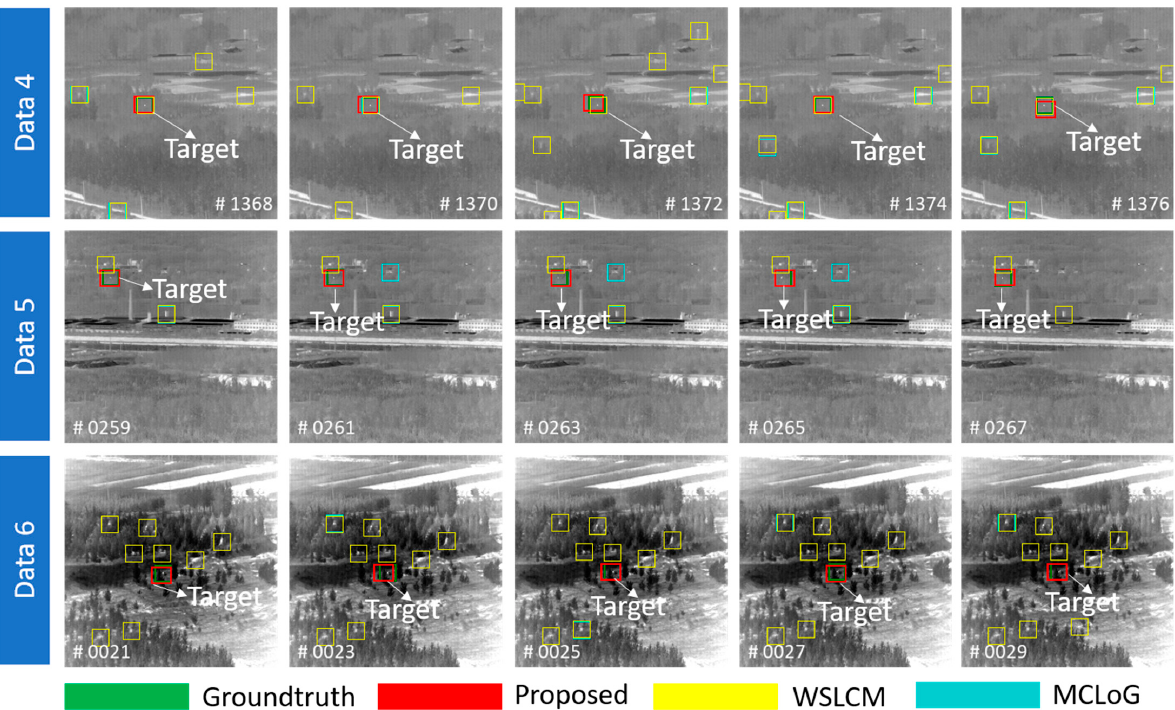
Figure 14. Detection results between our method and traditional single-frame-based methods in public datasets. The target has been marked by texts, and the other prediction boxes are false alarms. Experimental results show that the conventional single-frame algorithm has a high false alarm rate except for the proposed method.